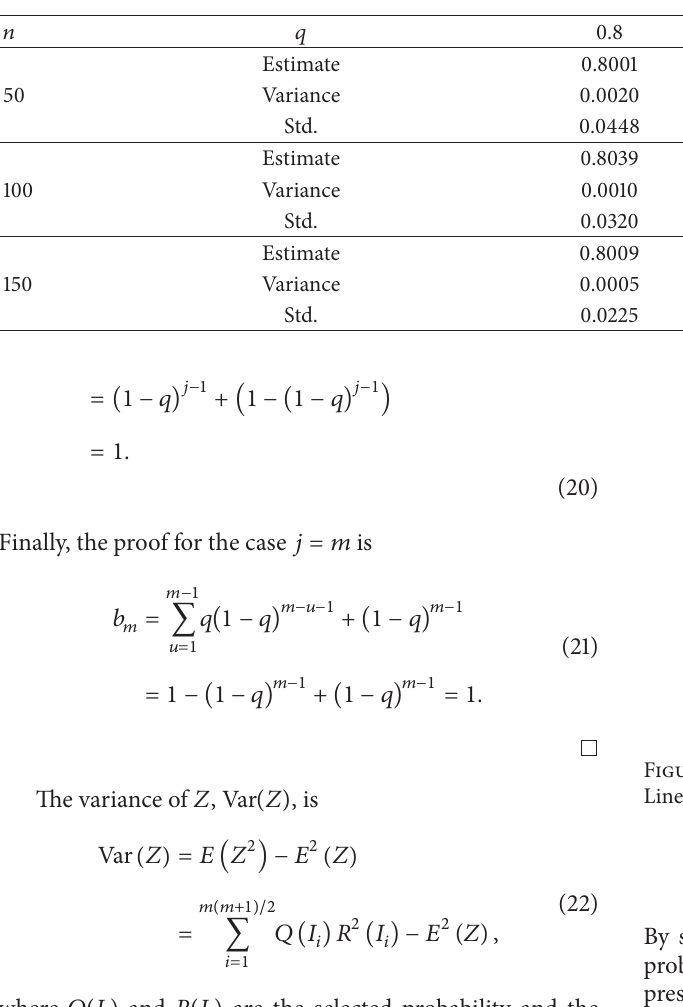
Table 3: The mean, sample variance, and sample deviation of ̂𝑞 .